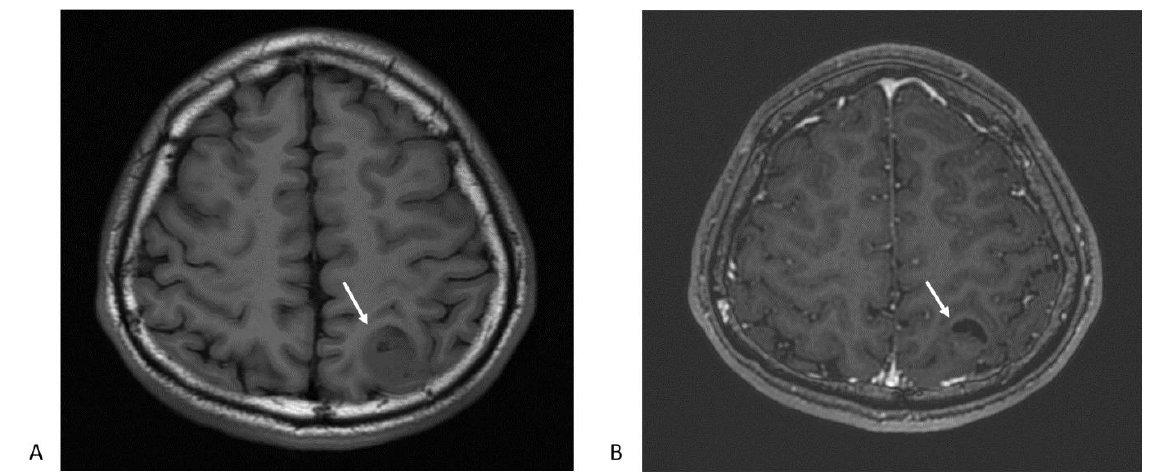
Figure 1. Magnetic resonance imaging (MRI) typical features glioblastoma multiforme: ( A ) The axial T1-weighted image shows heterogeneous hypointense mass lesion at left parietal lobe (arrow); ( B ) postcontrast T1-weighted axial image depicts an enhancing ring lesion with central heterogeneous enhancement. The crescent-shape dark area suggests a necrotic part of the tumor (arrow).